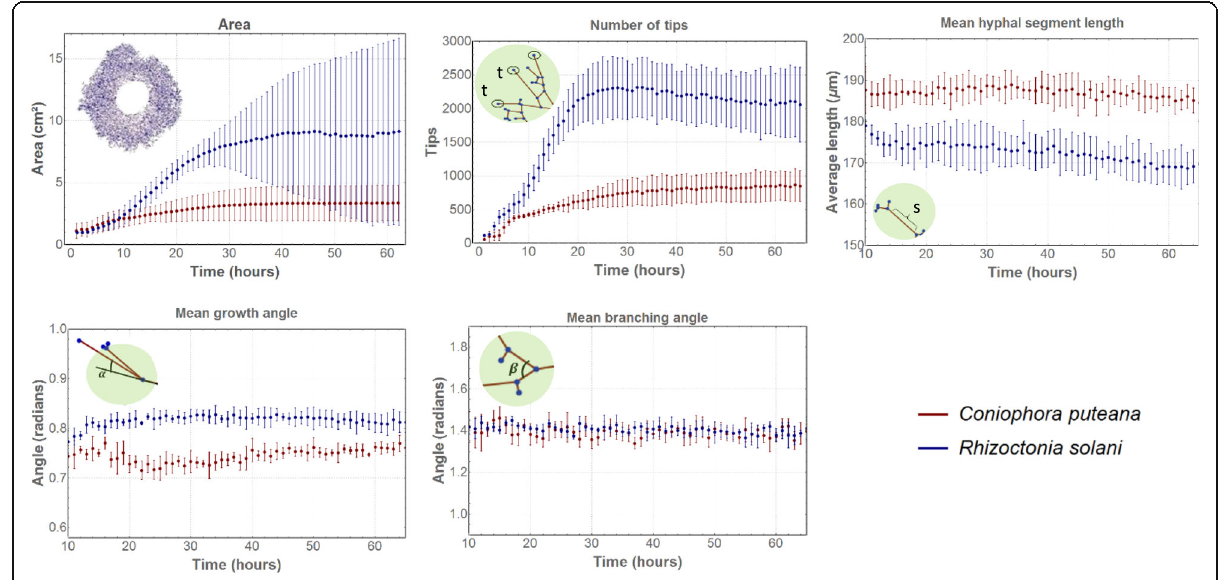
Fig. 3 Fungal growth characteristics in function of time at 25 °C and 80% RH for C. puteana (red) and R. solani (blue). The dots represent the average value of four replicates, with the bars indicating the standard